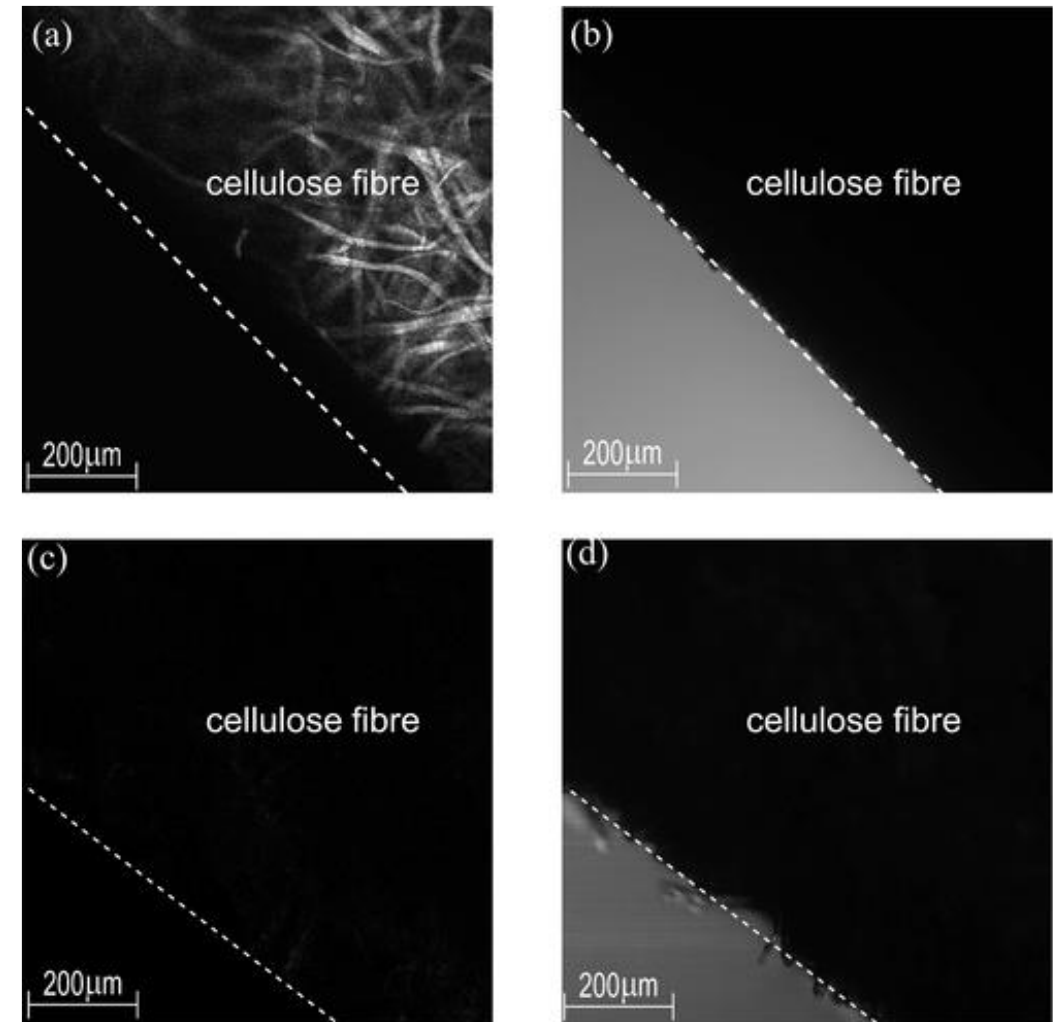
Figure 3. Fluorescence spectroscopy images. ( a ) Cel- g - N -(1-pyrene)-maleimide, ( b ) Cel- g - N -(1-pyrene)-maleimide, ( c ) blank sample, and ( d ) transmission image of blank sample. (Copyright and permission, ACS publication